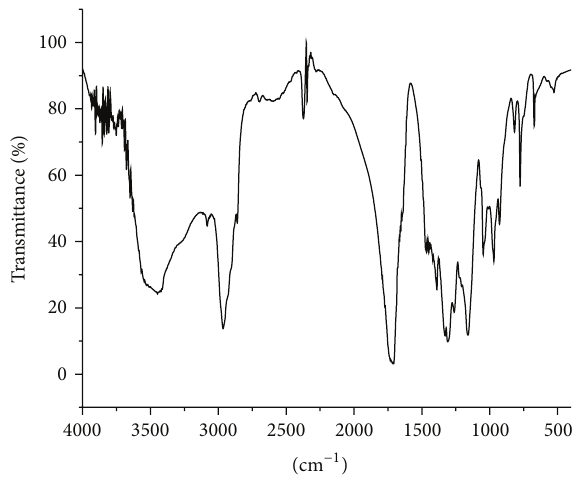
Figure 1: FT-IR spectrum of copolyester PIFB.